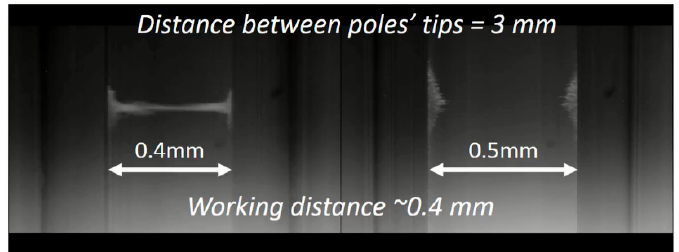
Figure S1. The area between two electromagnets in which the magnetic moment of the M-280 beads saturates. The spatial distribution of the magnetic field surrounding two electromagnets with parabolic pole tips ( 𝛽 = 0.65 ) that are located 3 mm opposite each other. The contours represent the magnetic field magnitude. The magnetic moment of the M-280 beads saturates at an external field strength above 0.3 Tesla (marked with a thick blue line). Therefore, the magnetic moment of the magnetic beads saturates when the beads are located less than 2 mm from the pole tips.